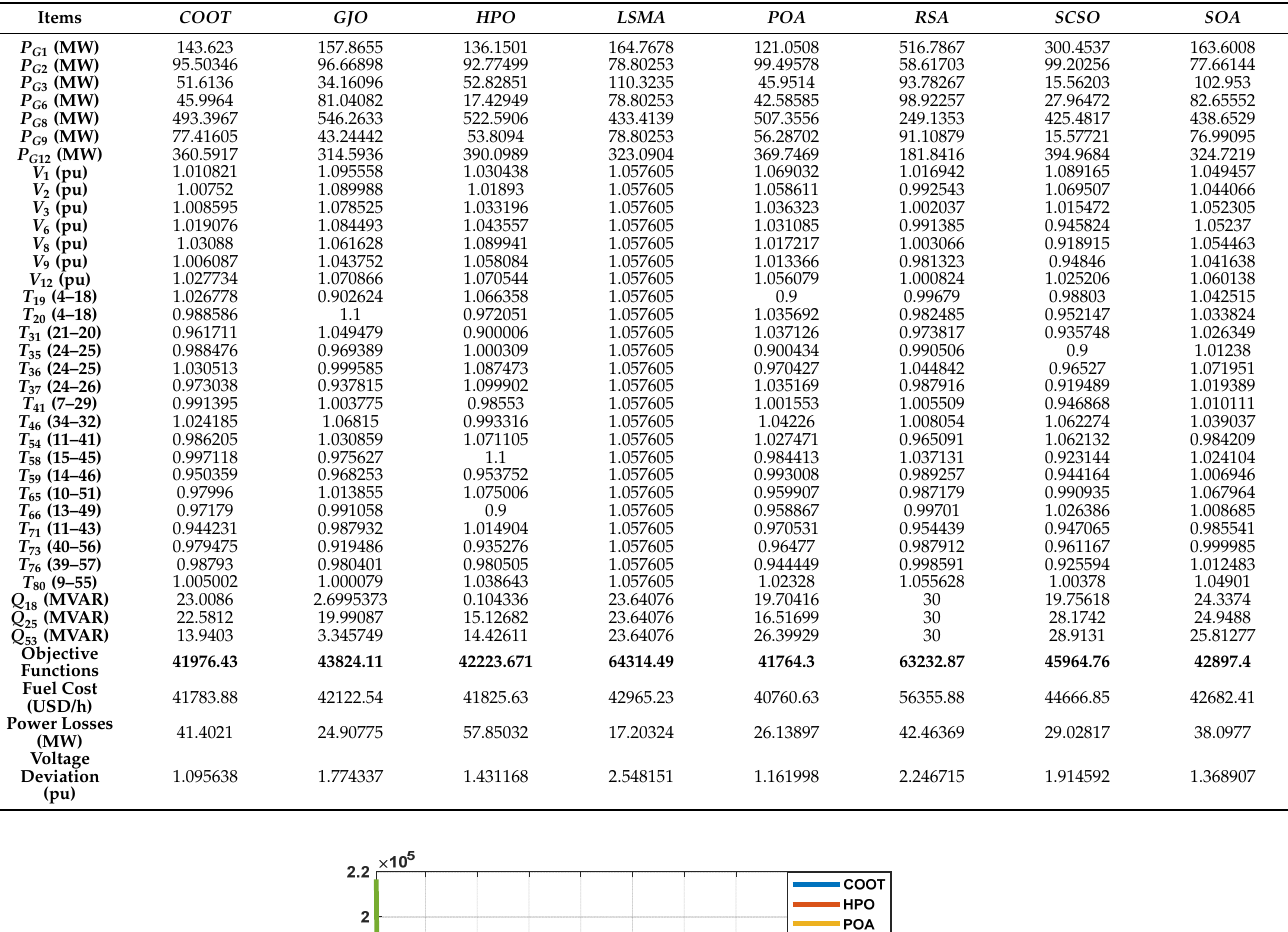
Table 10. Optimal control variables for the IEEE 57-bus test system for minimizing multi-objective function without emissions.